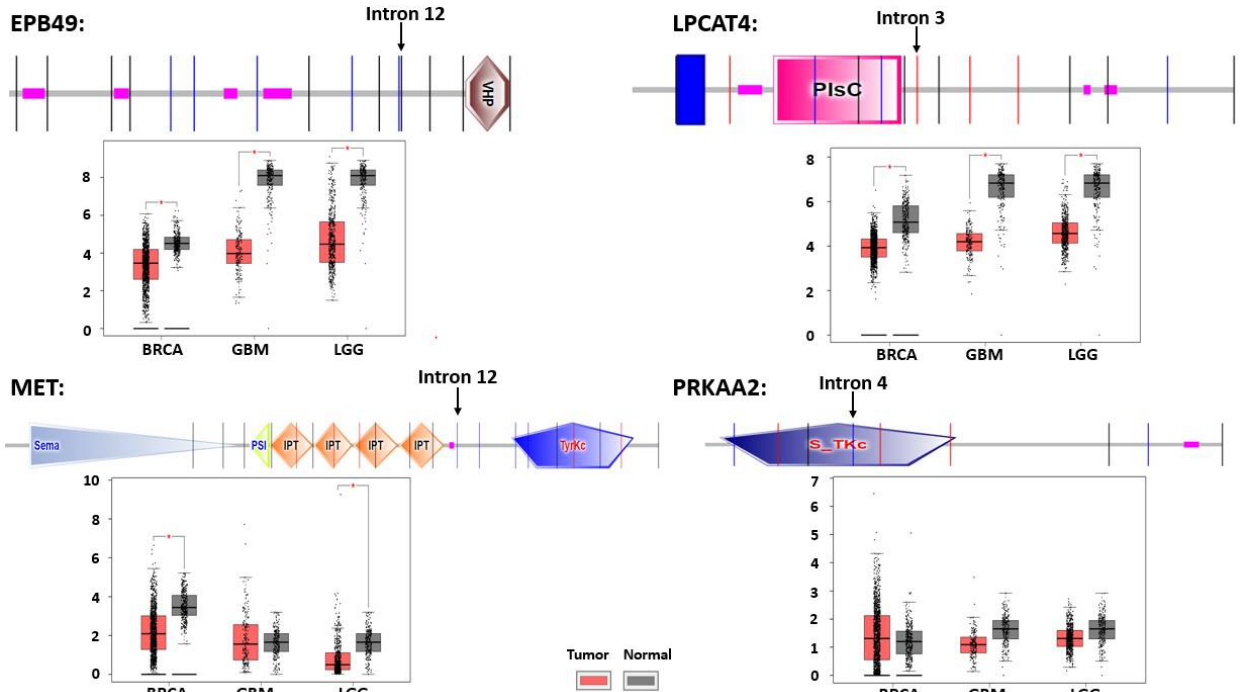
Figure 5. Representative gene transcripts which showed activation of latent splicing in both breast cancer cells and neuronal tumors (MCF-7 breast cancer cells; glioma and oligodendroglioma grade II and III tumors) [31]. Diagram of the protein domains, based on SMRT EMBL database, where the location of the activated LSS [31] is marked; the vertical lines refer to intron locations. EPB49, contains a low complexity region (pink box) and a VHP (Villin headpiece) catalytic domain; LPCAT4, harbors a transmembrane domain (blue box), a low complexity region (pink box), and a PlsC (Phosphate acyltransferase) domain; MET, contains a Sema (semaphorin domain), PSI domain (found in several different extracellular receptors, including plexins, which are involved in the development of neural and epithelial tissues), IPT (Ig-like, plexins, transcription factors) domain, low complexity region (pink box), and the catalytic domain TyrKc (Tyrosine kinase); PRKAA2, carries a catalytic domain S_TKc (Serine/Threonine protein kinases), and a low complexity region. Below each protein diagram, the expression of the respective gene is presented, as tested in 1085, 163, and 518 BRCA, GBM and LGG tissue samples, respectively, and in 291, 207, and 207 non-tumor tissues, based on data from GEPIA. BRCA, breast invasive carcinoma; GBM, glioblastoma multiforme; LGG, brain lower grade glioma. Red star indicates significant difference between tumors and normal tissues ( p value ≤ 0.01).